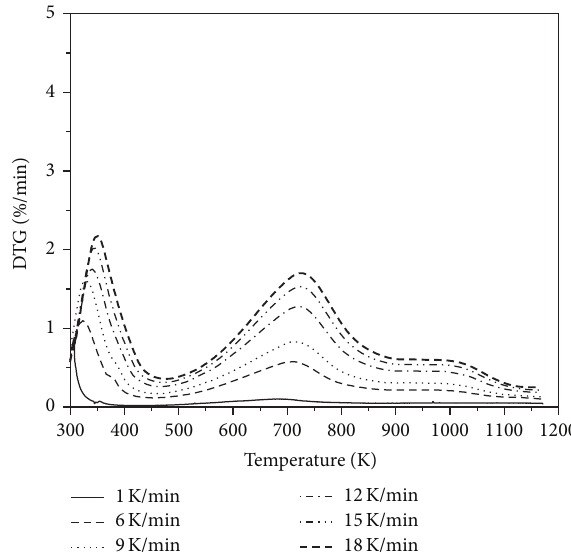
Figure 2: DTG curves of Poplar coal at different heating rates under N 2